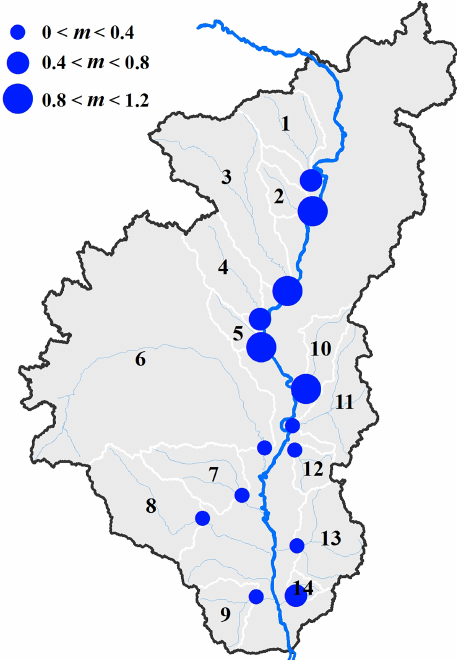
Figure 10. Spatial distribution of slope m in the regression equation SC = − mA c + n . SC is the decadal average sediment coefficient, and A c is the percentage of the area affected by soil and water con- servation measures in the